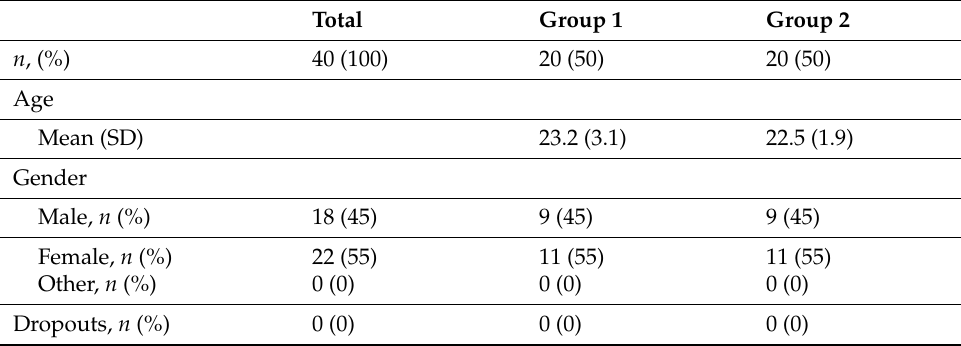
Table 1. Participants’ general